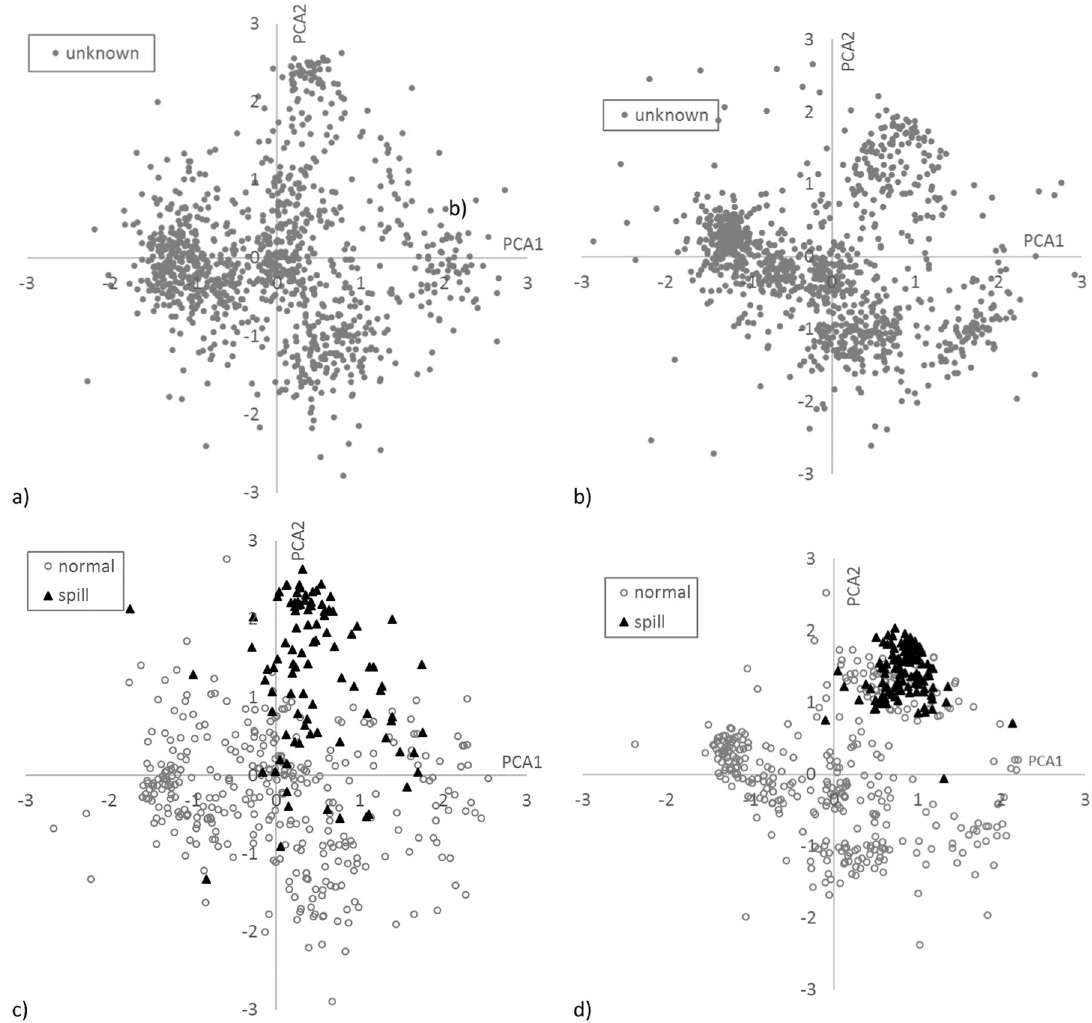
Fig. 3 PCA1 vs PCA2 for daily fl ow patterns. Unknown spill status (grey fi lled circles); spill con fi rmed by EDM ( fi lled black triangles); con fi rmed as normal by EDM (un fi lled grey circle) 2016 – 2018 without EDM data a WWTP1 ( n = 1065); b WWTP2 ( n = 1056); 2018 – 2020 with EDM data c WWTP1 ( n = 466); d WWTP2 ( n =